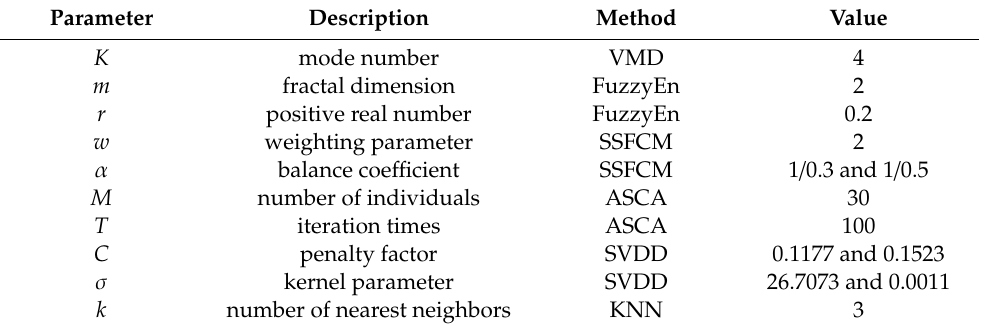
Table 4. Value of parameter in the